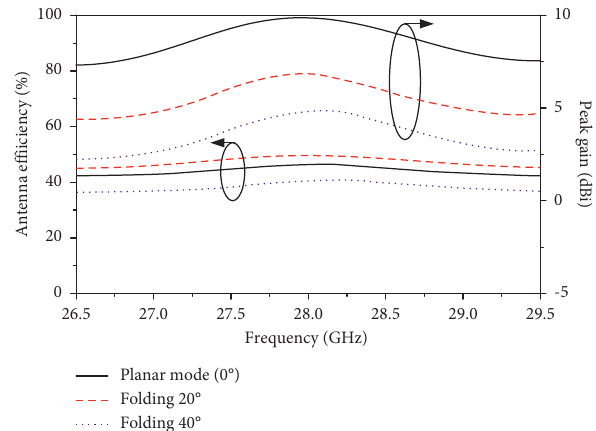
Figure 20: Antenna efficiency and realized peak gain of the 4 × 4 patch array under different folding